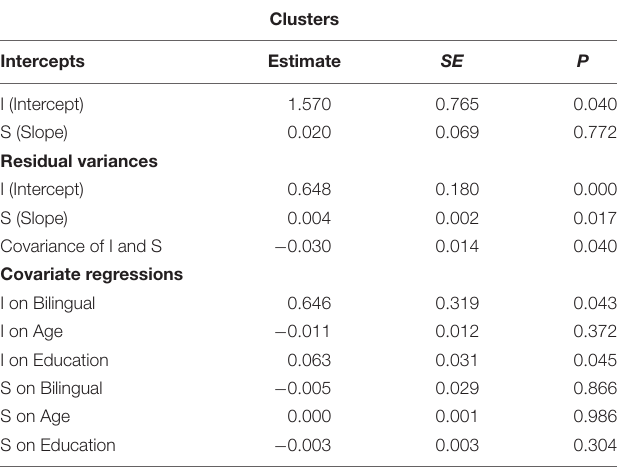
TABLE 6 | Estimates from the Conditional LGM modeling clusters using biligualism, age, and education as covarietes. Clusters